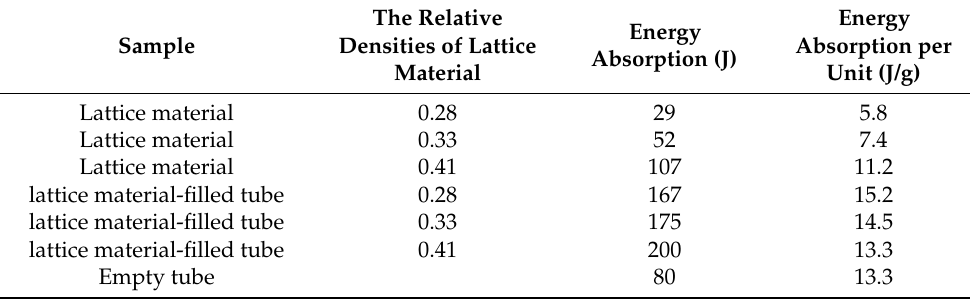
Figure 13. Energy absorption per unit volume of the pyramid lattice material-filled tube with lattice materials of different relative densities ( a ) 0.28, ( b ) 0.33, ( c ) 0.41. Table 2. Energy absorption per unit mass of the pyramid lattice material-filled tube, lattice material, and empty tube. Sample